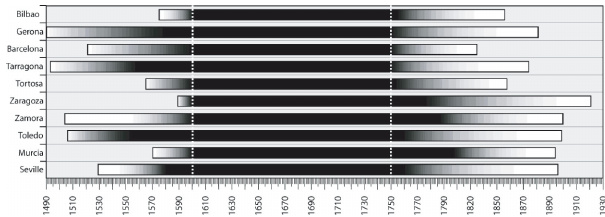
Fig. 2. Length of rogation series. Darker areas denote a higher confidence in rogation series